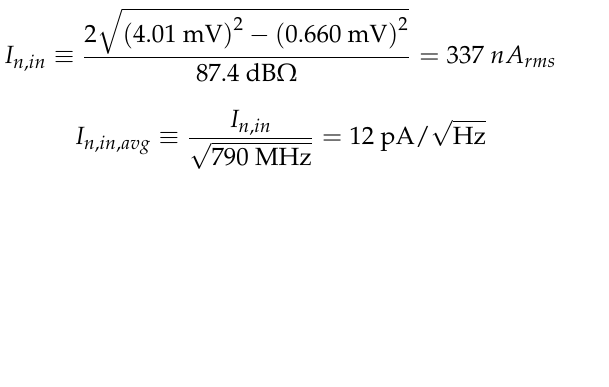
Figure 11. Measured noise output voltage of the proposed Rx IC.